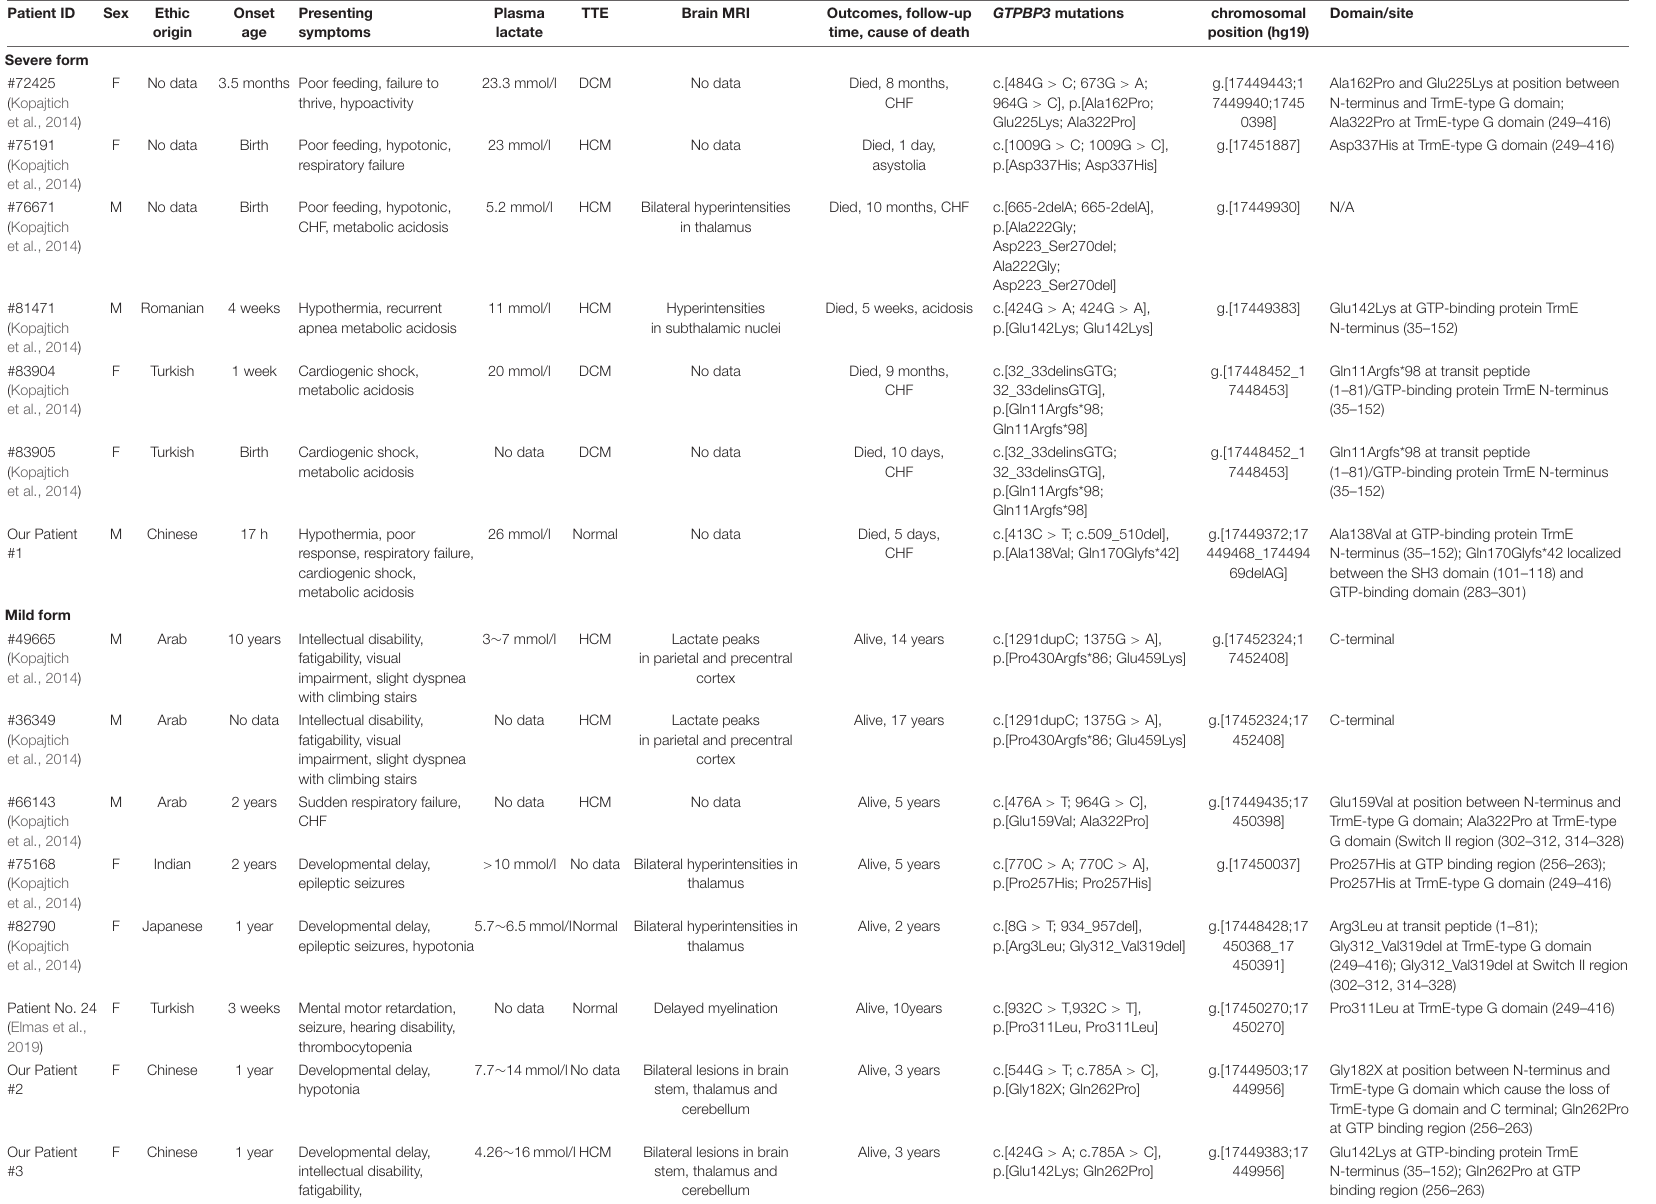
CHF, congestive heart failure; DCM, dilated cardiomyopathy; HCM, hypertrophic cardiomyopathy; N/A, not applicable; TTE, transthoracic